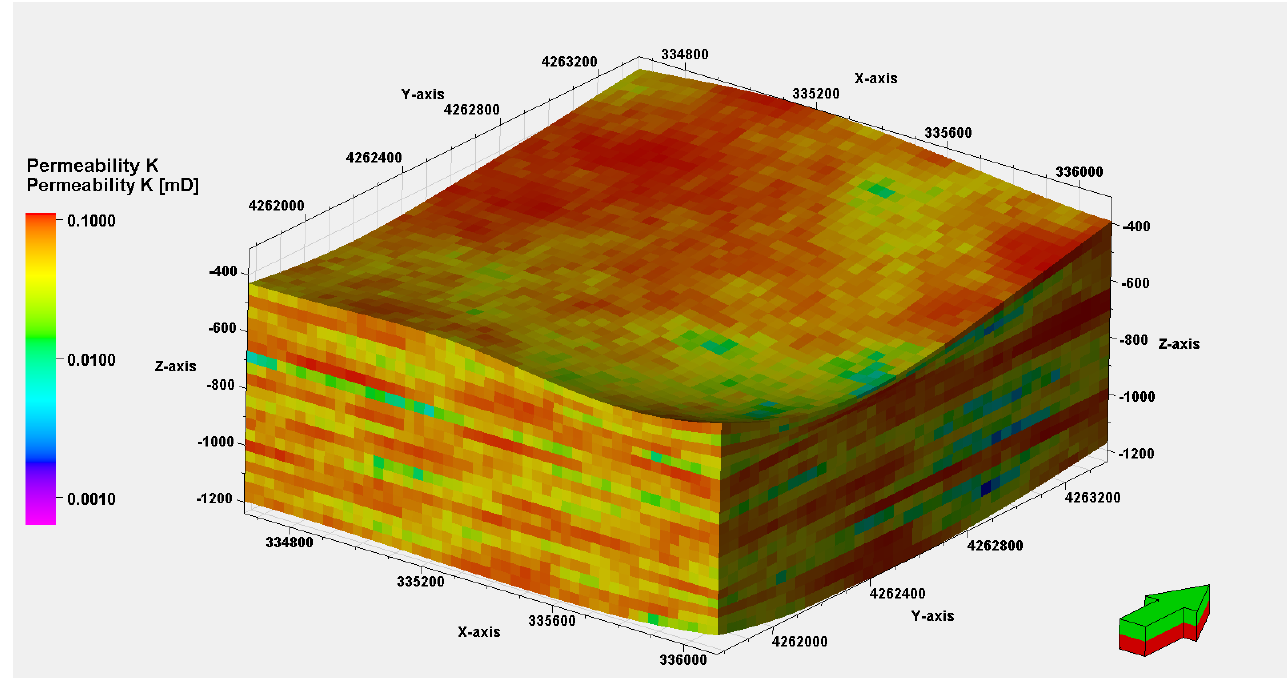
Figure 7. Vertical permeability distribution in the model’s grid [2].